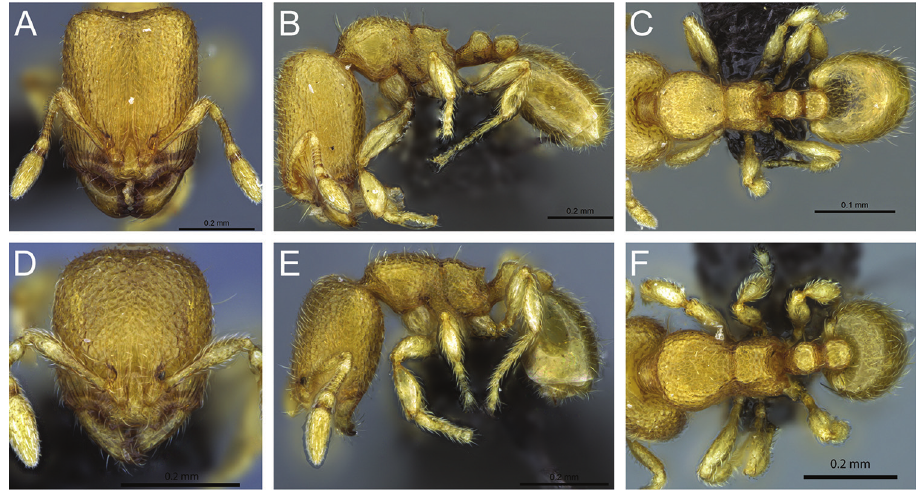
Figure 35. Carebara creolei –holotype. Major worker, CASENT0060366. A head in full-face view B body in profile view C body in dorsal view. Minor worker, CASENT0060670 D head in full-face view E body in profile view F body in dorsal